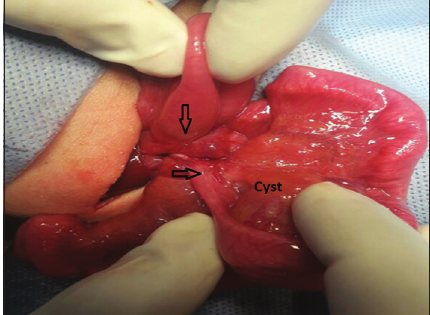
Figure 2: Cyst in the mesentery of jejunum. Arrows showed proximal and distal bowels at the site of atresia